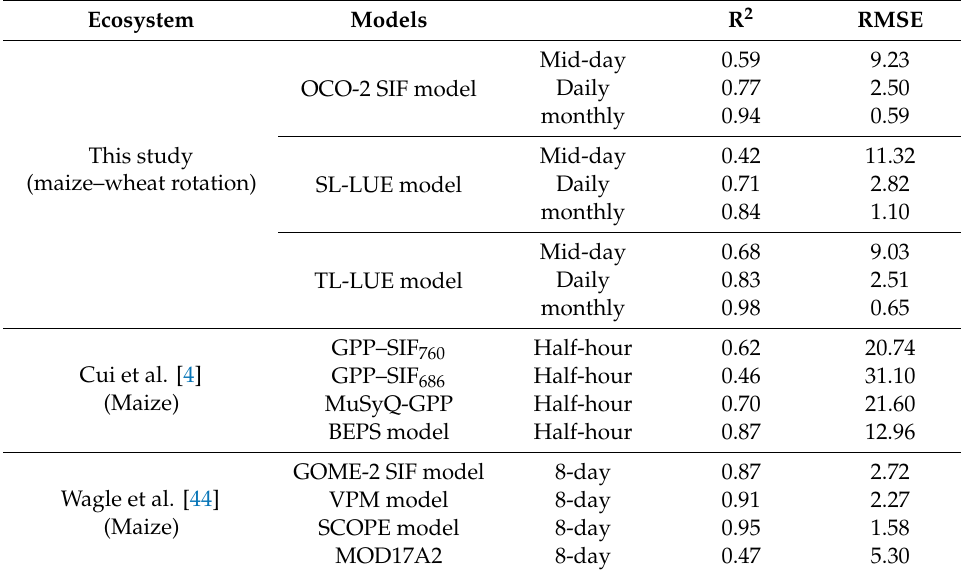
Table 6. The estimation performance among di ff erent GPP models in this study, from Cui et al. [4]